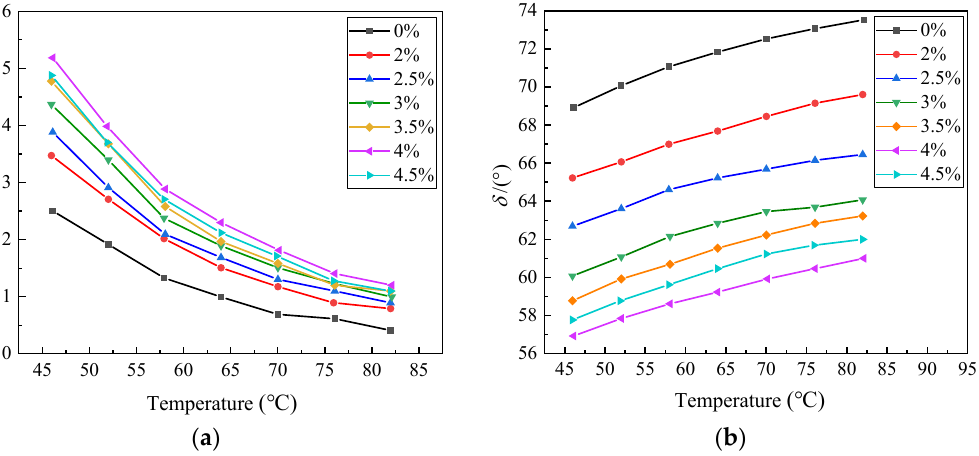
Figure 7. ( a ) The complex shear modulus of different content of SBS, ( b ) phase angle of different contents of SBS.